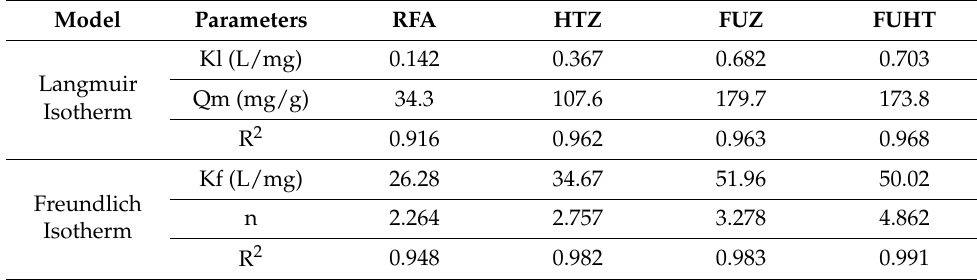
Table 4. Isothermal study for adsorption of Pb 2+ on RFA and